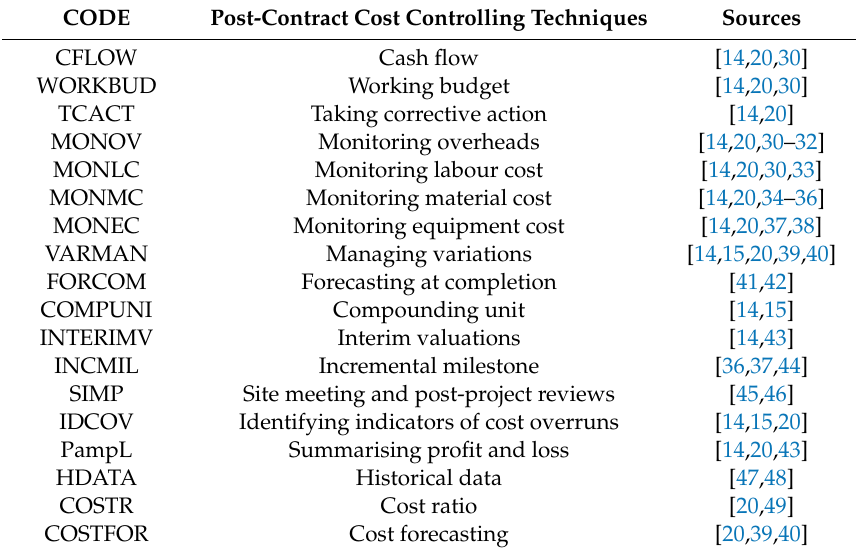
Table 1. Post-contract cost controlling techniques used in construction